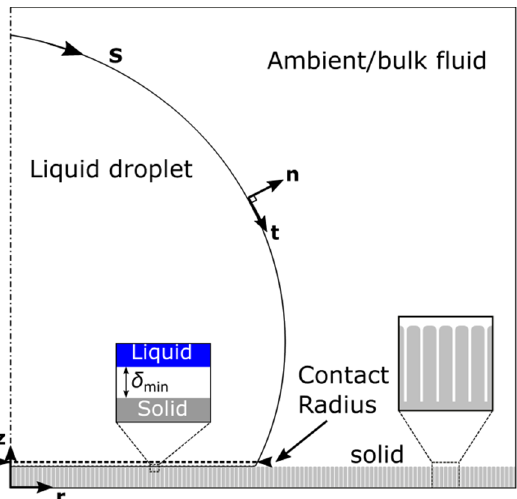
Figure 1. Illustration of the de-wetting/jumping setup of an axisymmetric droplet surrounded by a bulk fluid (air or oil) on a structured solid substrate.